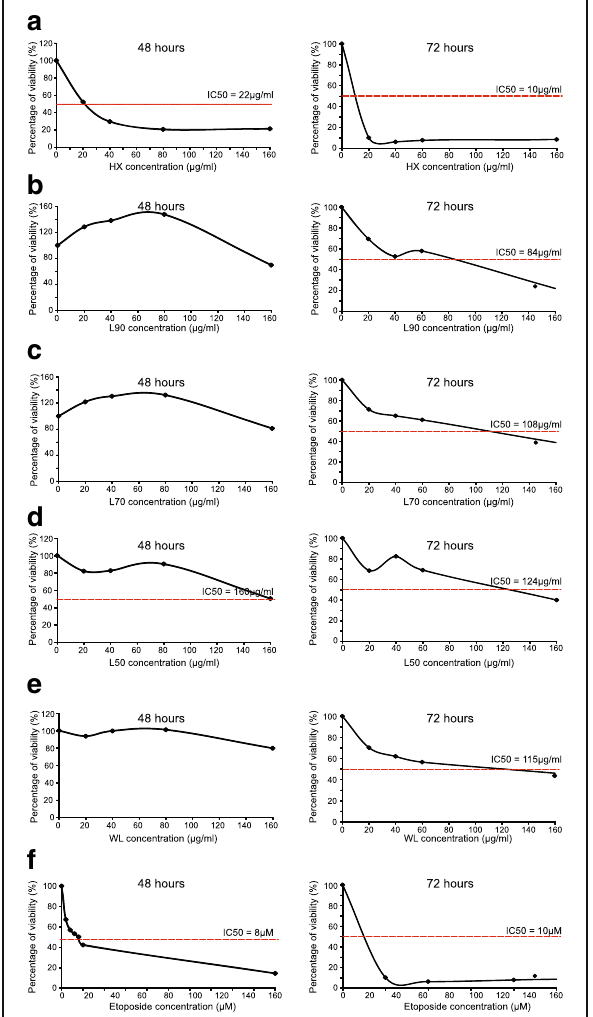
Fig. 2 Effects of B. frutescens leaves extracts on MCF-7 cell viability. Cytotoxicity was determined using cell viability assay and the IC 50 value determined as half maximal percentage of cell viability inhibition is indicated by the red horizontal line. MCF-7 cells were treated with either ( a ) hexane, b L90, c L70, d L50 or ( e ) water extract of B. frutescens leaves or ( f ) etoposide for 48 (left panels) or 72 (right panels) hrs. Etoposide served as the positive control. Data is expressed as mean±standard error mean based on six independent experiments with triplicate wells for each